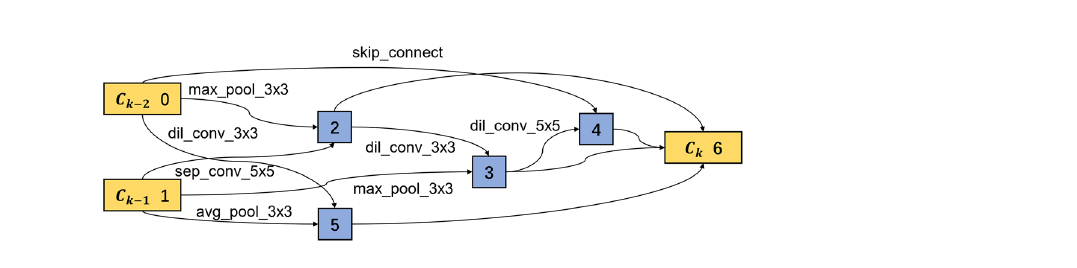
Figure 10. Learned reduction cell structure in the search phase.